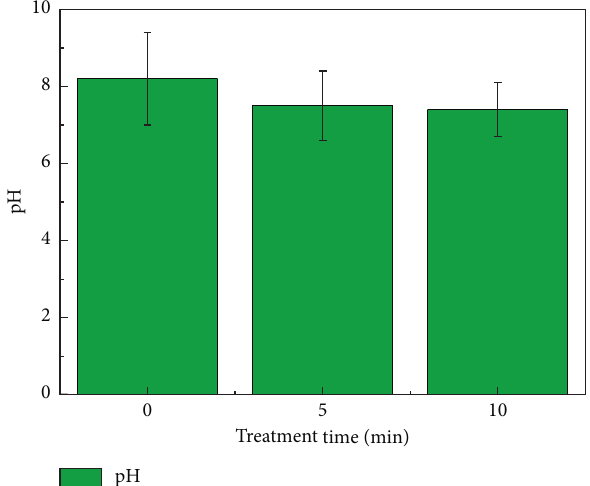
Figure 17: Variation of pH with treatment time (5kV, 19.56 kHz, and 5 L/min).